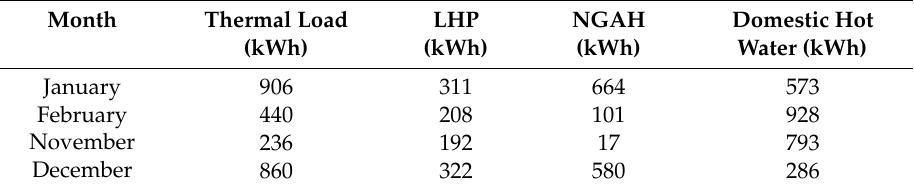
Table 9. Produced thermal energy in heating mode.